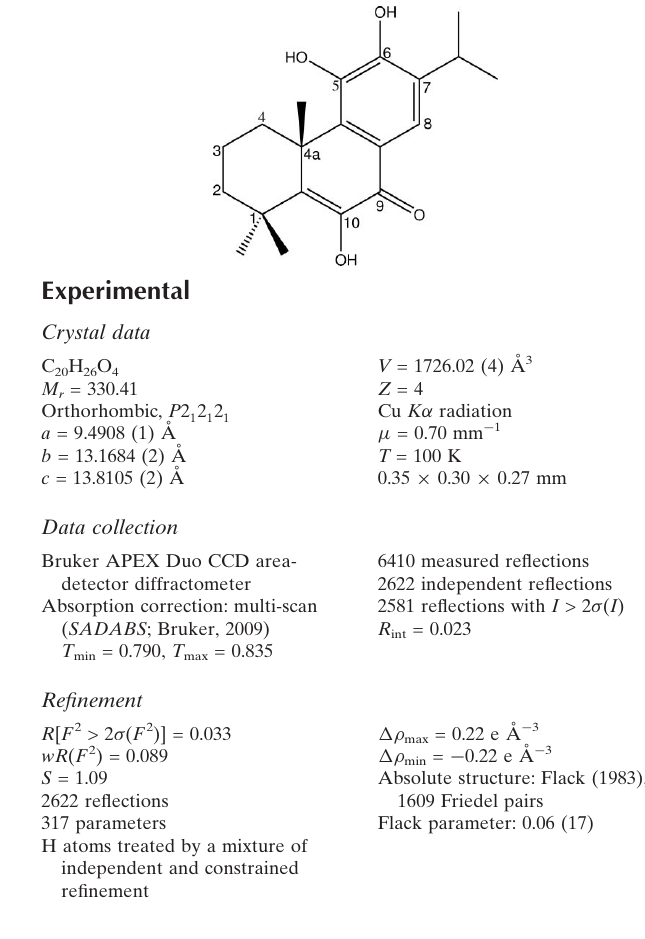
Bruker APEX Duo CCD area- detector diffractometer